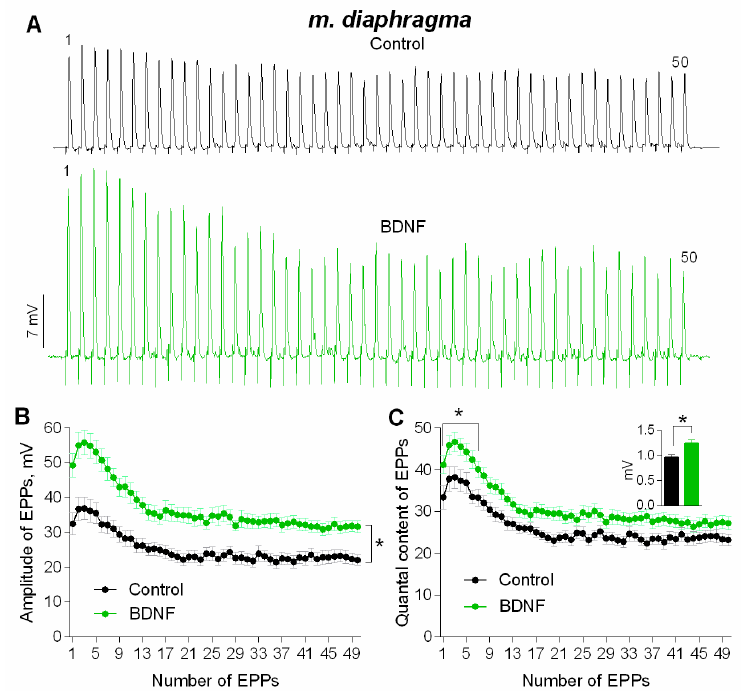
Figure 6. BDNF-induced potentiation of evoked neuromuscular transmission during short (1 s) high-frequency (50 Hz) trains at diaphragm NMJs ( A ) Representative recordings of EPPs in control (above) and after BDNF (1 nM) was added